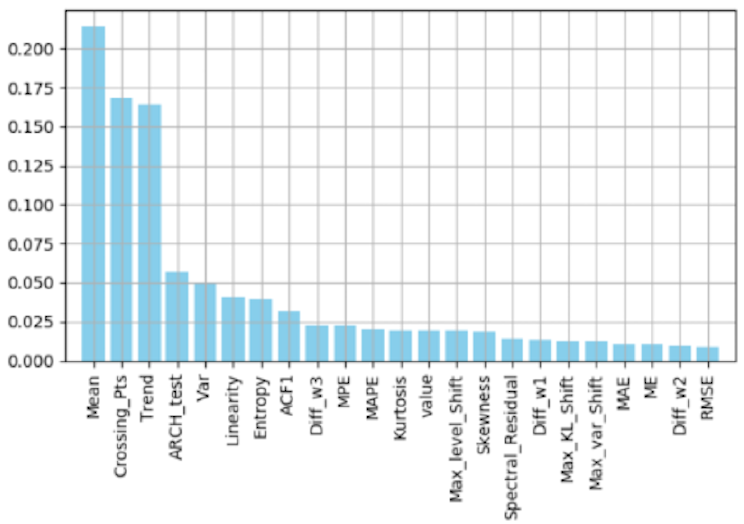
Figure 2. catch25 feature importance for Random Forest on Huawei dataset.